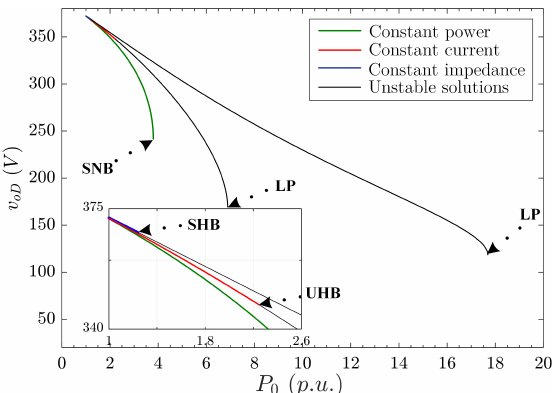
Figure 12. Bifurcation diagram for the different types of ZIP load models.